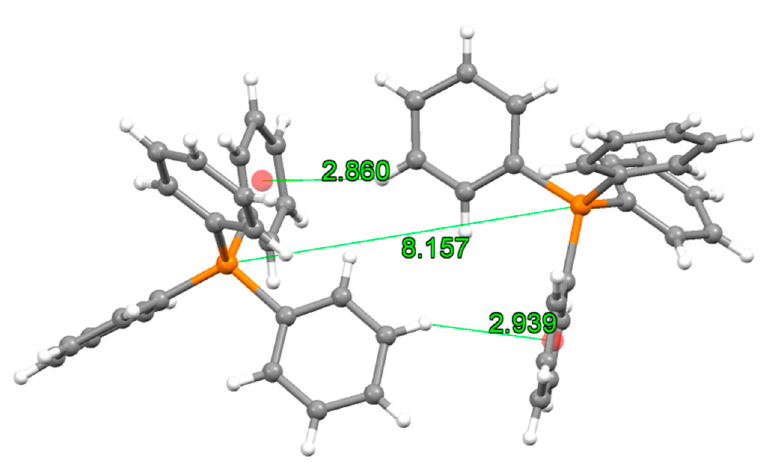
Figure 7. Interactions found between the closest (PPh 4 ) + cations in the structure of 6 . Distances are shown in Å.